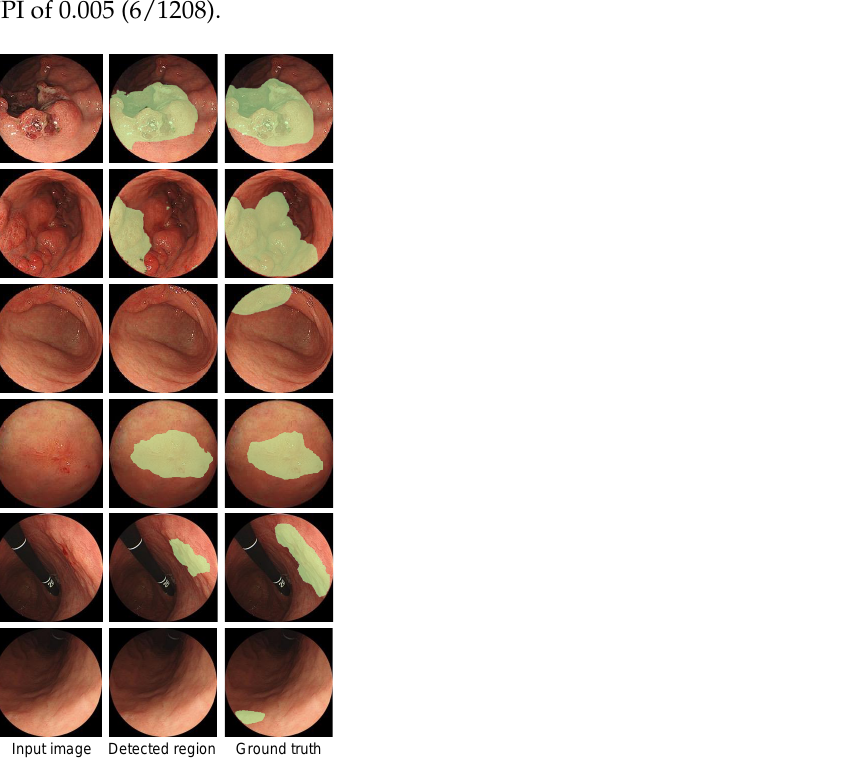
Figure 6. Lesions detected and missed in the segmentation phase: ( a , b ) correctly detected region of advanced gastric cancer; ( c ) missed region of advanced gastric cancer; ( d , e ) correctly detected region of early gastric cancer; ( f ) missed region of early gastric cancer. Table 3. Evaluation results of cancer segmentation.